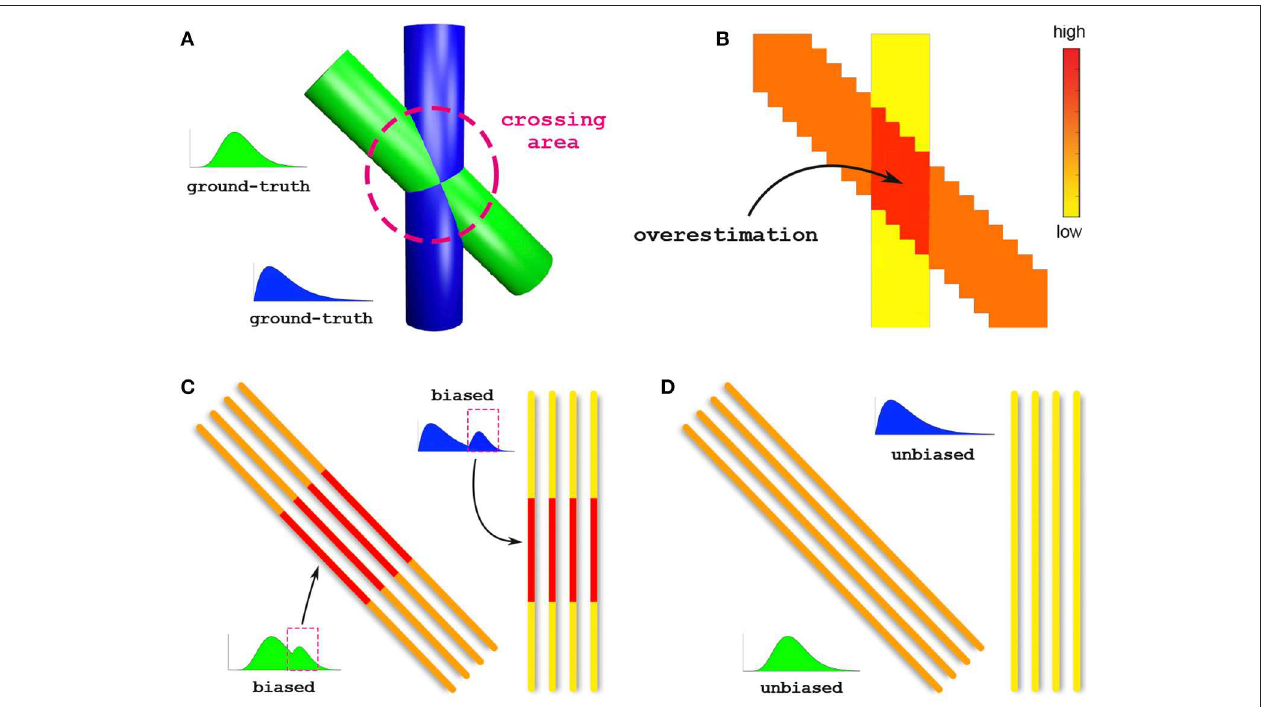
FIGURE 1 | Voxel-wise vs. bundle-specific axon diameter estimation. (A) Schematic illustration of two crossing fiber populations characterized by different compositions: the green bundle contains larger axons than the blue. (B) Axon diameter estimation using a voxel-wise approach; for simplicity, we report the estimated mean diameters. The arrow points to the crossing region where such methods are known to especially suffer from overestimation. (C) Characterization of the axon diameter of a white matter bundle is typically done by averaging, along its entire course, the values previously estimated in every voxel; this indirect procedure is affected by such overestimated voxels and leads to biased results. (D) Estimation of bundle-specific axon diameter.